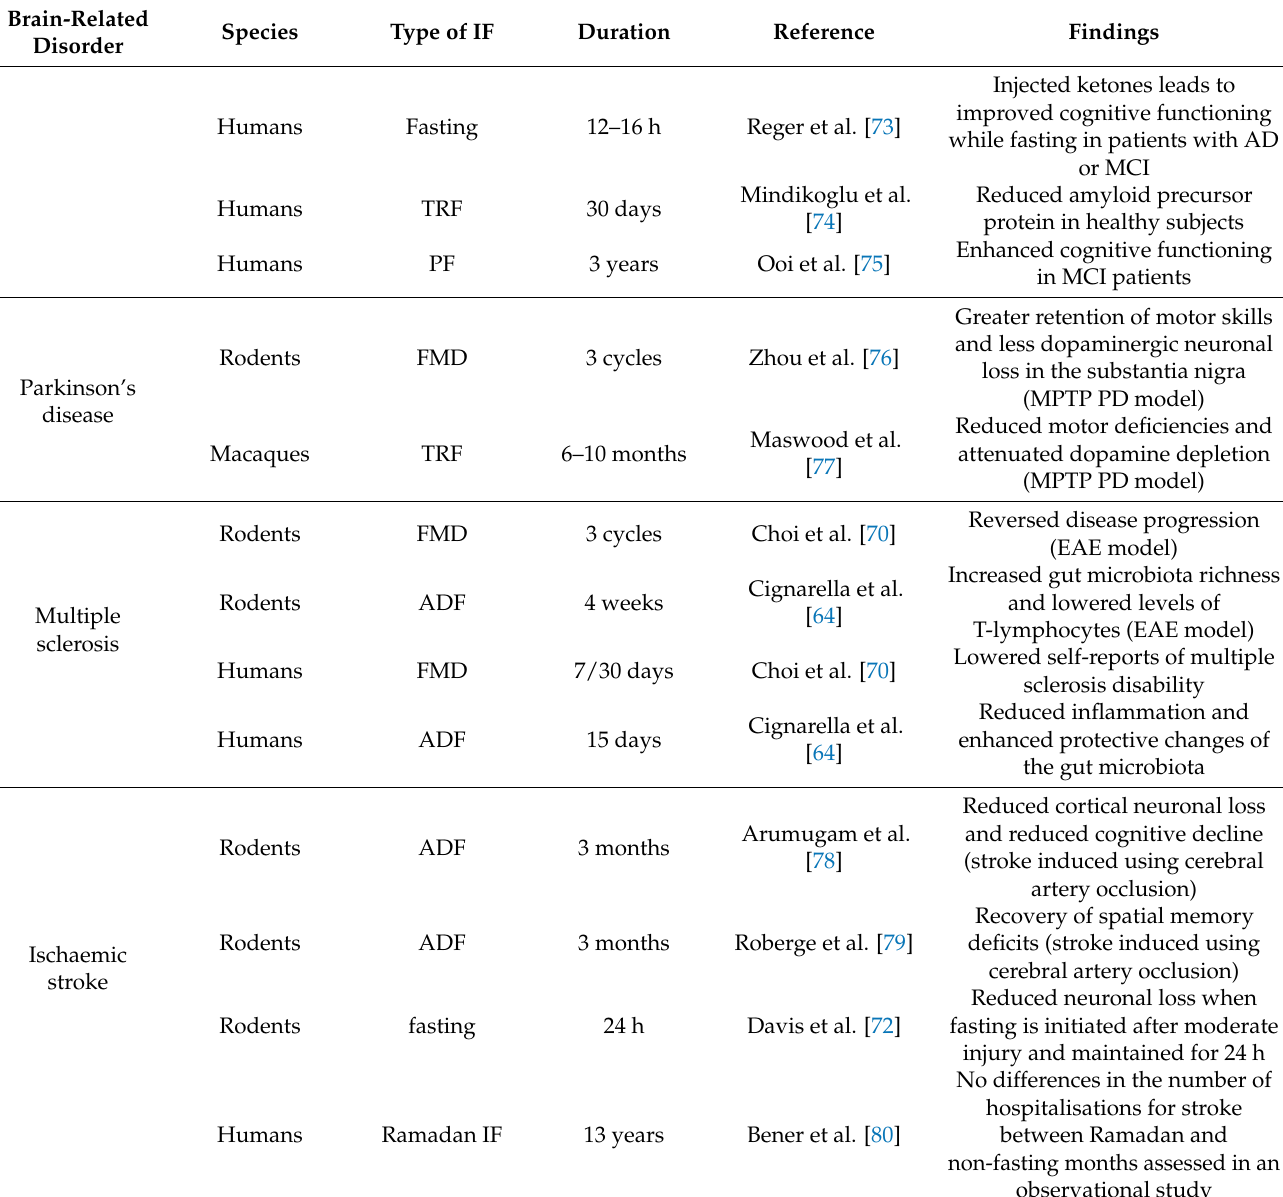
Table 1. Characteristics of relevant preclinical and clinical studies on Alzheimer’s disease, Parkinson’s disease, multiple sclerosis, ischemic stroke, epilepsy, autism spectrum disorder, and mood- and anxiety disorders (see note below).